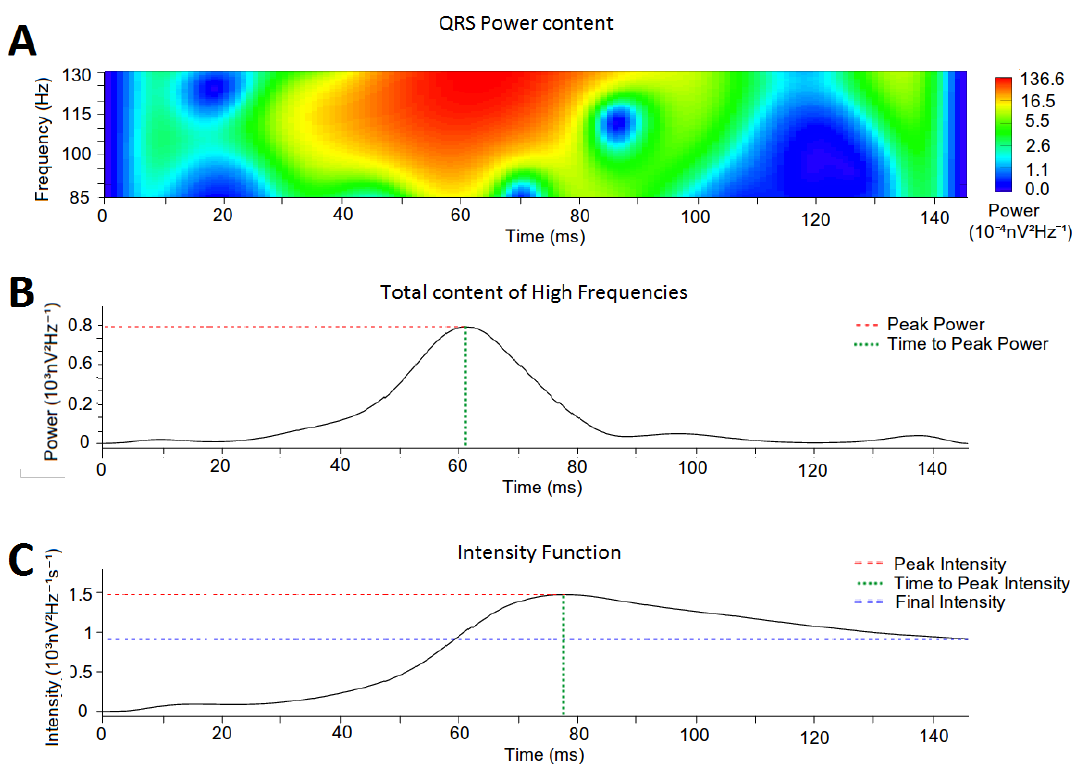
Figure 3. Example of a Wavelet continuous transform on a QRS complex (frequency range: 85–130 Hz). ( A ) Power spectrum of the QRS complex. ( B ) Cumulative power of the high-frequency content at each time epoch. The red dotted line marks the Peak Power and the green dotted line marks the Time to Peak Power . ( C ) Intensity Function. Final Intensity is marked by blue dotted line; Time to Peak Intensity is marked by the green dotted line; and Peak Intensity is marked by the red dotted line.